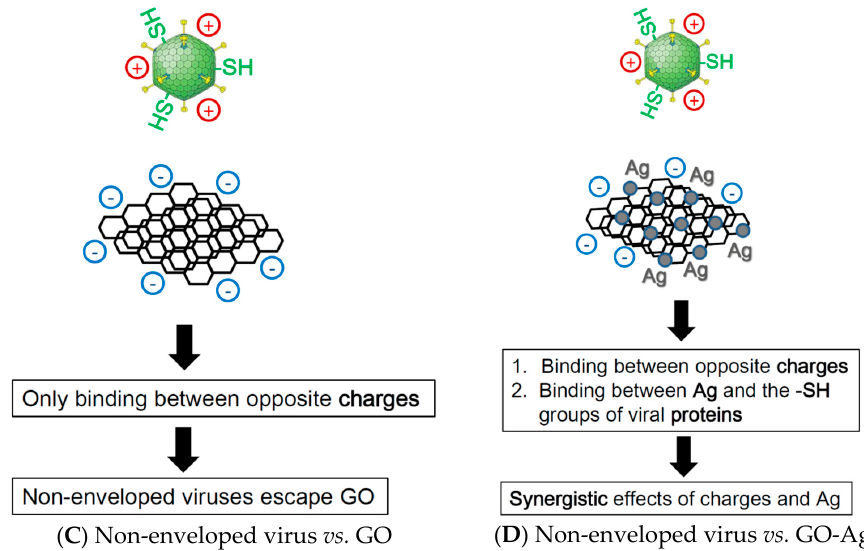
( C ) Non-enveloped virus vs. GO ( D ) Non-enveloped virus vs. GO-Ag Figure 7. Schematic for the antiviral mechanisms of ( A ) graphene oxide (GO) against the enveloped virus; ( B ) graphene-silver nanocomposites (GO-Ag) against the enveloped virus; ( C ) GO against the non-enveloped virus; ( D ) GO-Ag against the non-enveloped virus.